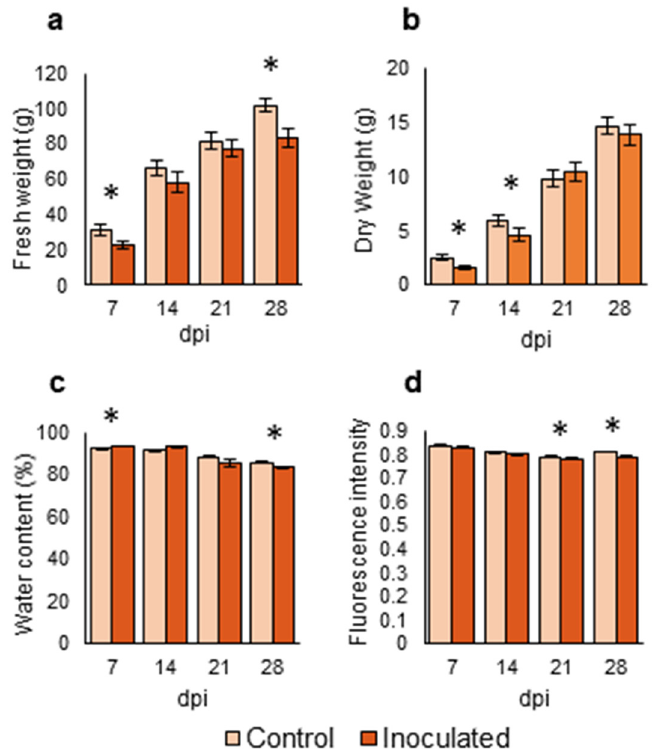
Figure 4. Parameters related to biomass and physiology of Brassica oleracea seedlings inoculated with Xanthomonas campestris pv. campestris under greenhouse conditions. ( a ) Fresh weight ( b ). Dry weight ( c ). Water percentage ( d ). Levels of fluorescence. Measurements were done at 7, 14, 21 and 28 days post inoculation (dpi). Data represent the averages of 12 repetitions, representing four crops ( B. oleracea var. botrytis , B. oleracea var. italica, B. oleracea var. capitata , and B. oleracea var. acephala ). Asterisks indicate significant differences at p < 0.05. Bars represent the standard errors.